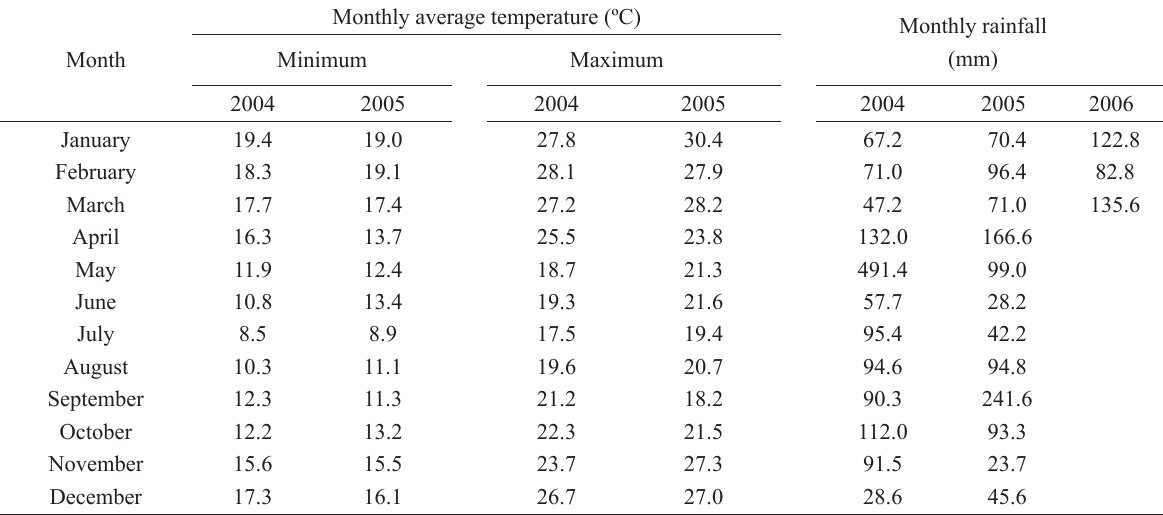
Weather conditions of the experimental feld located at the municipality of Capão do Leão, in the State of Rio Grande do Sul, Brazil (1)